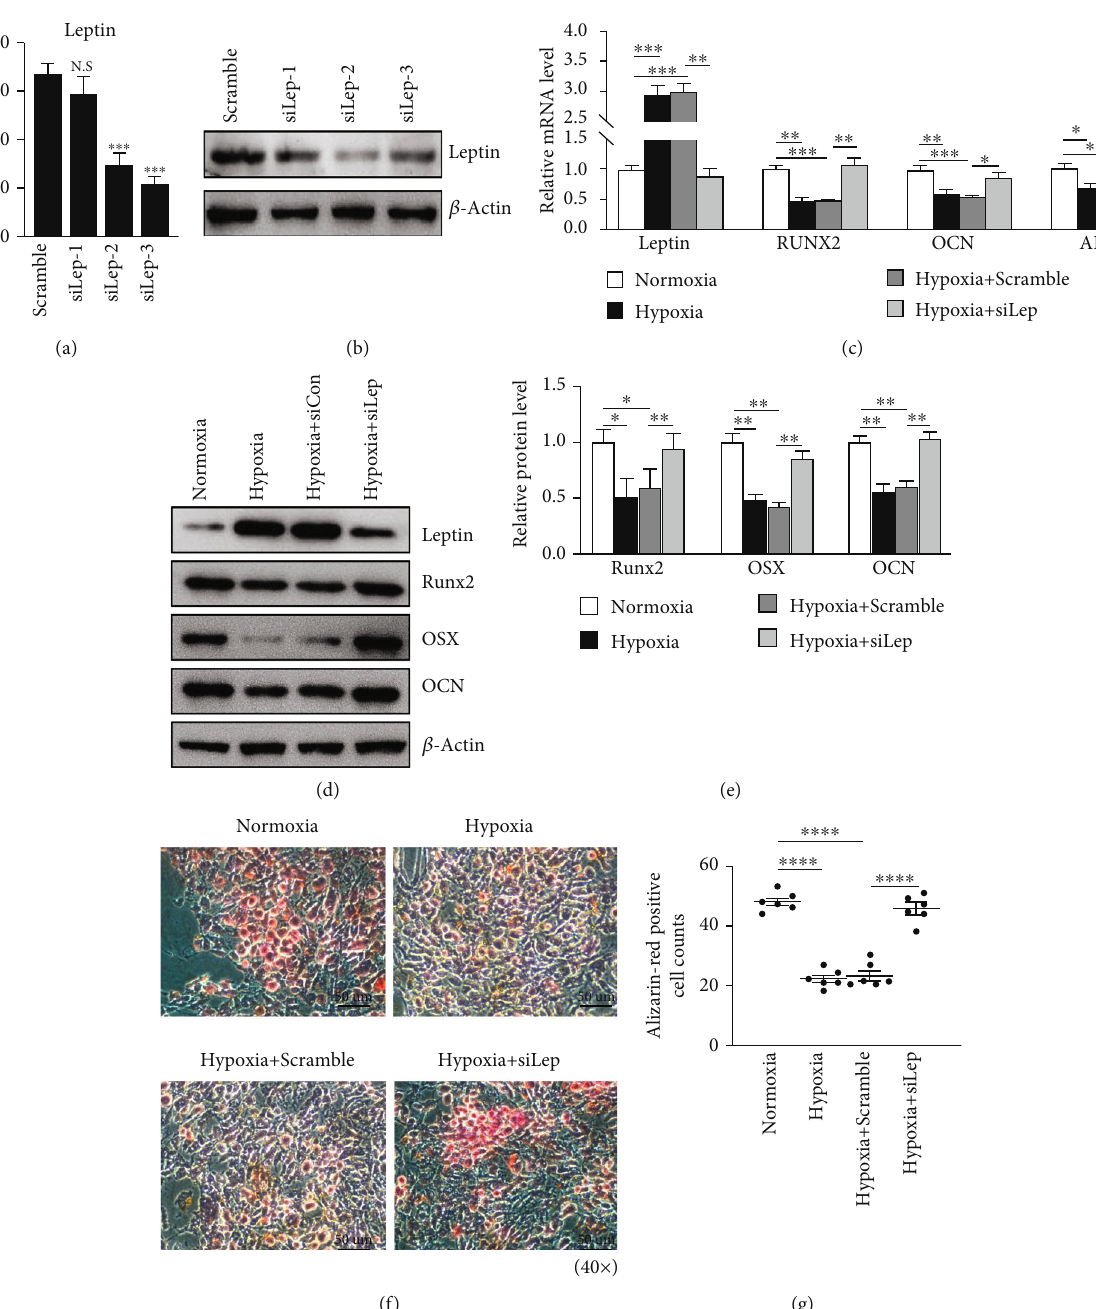
Figure 4: Knockdown of leptin reversed the hypoxia-mediated reduction of osteogenesis of RA-FLSs under hypoxia condition. (a) The knockdown e ffi cacy of siRNAs targeting leptin evaluated by RT-qPCR. NC: Negative Control; siLep: siRNA-leptin. Data quanti fi cation is mean ± SEM ( t -test, three independent experiments). (b) The absence of leptin in RA-FLSs was analyzed by Western blot. Data quanti fi cation is mean ± SEM ( t -test, three independent experiments). (c) RT-qPCR analysis of leptin and osteogenesis-related genes (Runx2, Ocn, and Alp) in leptin-knockdown or scrambled siRNA control RA-FLSs after culture with osteogenic induction medium for 3 days under hypoxia and normoxia condition. Data quanti fi cation is mean ± SEM ( t -test, three independent experiments). (d, e) Westernblot shows leptin expression and osteogenesis-related proteins (RUNX2, OSX, and OCN) in leptin-knockdown or scramble siRNA control RA-FLSs after culture with osteogenic induction medium for 3 days under hypoxia and normoxia condition. The expression normalized with β -actin. Data quanti fi cation is mean ± SEM ( t -test, three independent experiments). (f) Alizarin Red staining of the leptin-knockdown or scrambled siRNA control RA-FLSs after culture with osteogenic induction for 21 days under hypoxia and normoxia conditions. (g) Alizarin Red positive cells per fi eld were counted. Data quanti fi cation is mean ± SEM . ( t -test, six randomized fi elds, three independent experiments, and one representative experiment shown). ∗ p < 0 : 05 ; ∗∗ p < 0 : 01 ; ∗∗∗ p < 0 : 001 ; ∗∗∗∗ p < 0 : 0001 . Scale bars: C = 50 μ m